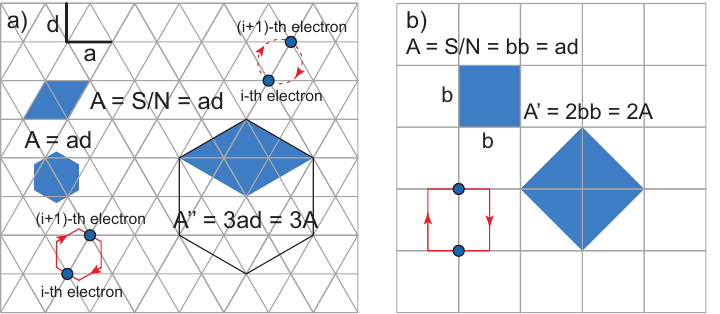
Figure A3. Wigner 2D square lattice of electrons ( b ) with indicated nearest neighbors and next- nearest ones compared to triangle lattice ( a ). The geometricized shape of the cyclotron orbit in hexagonal ( a ) and square 2D lattice ( b ) shown by contours deformed from the circular shape by the electron repulsion. These orbits allow the exchange of closest electrons in the Wigner lattice (semi-loops of cyclotron orbits build 2D braids for interacting electrons at magnetic field